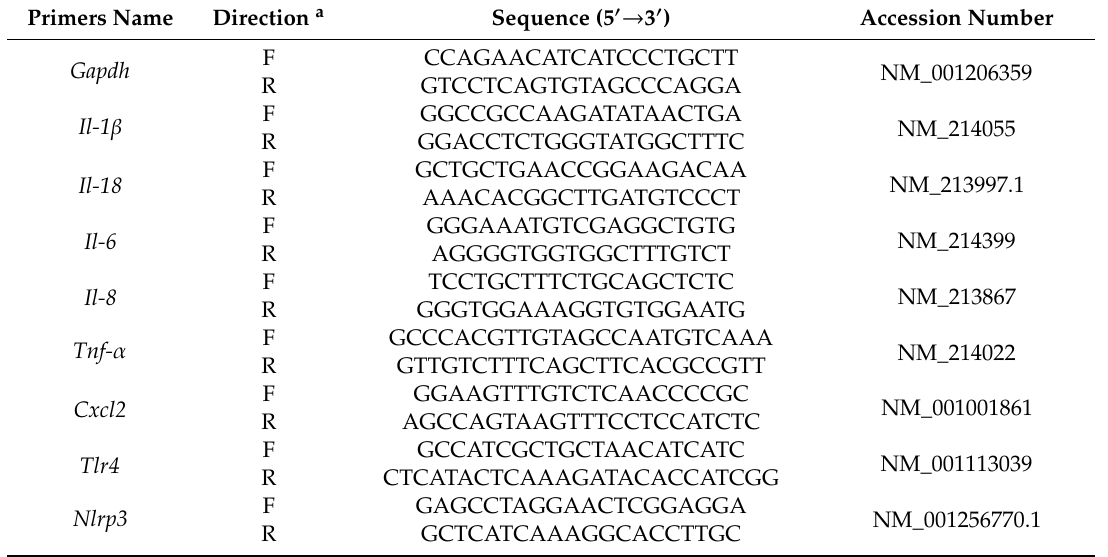
Table 1. Real-time PCR